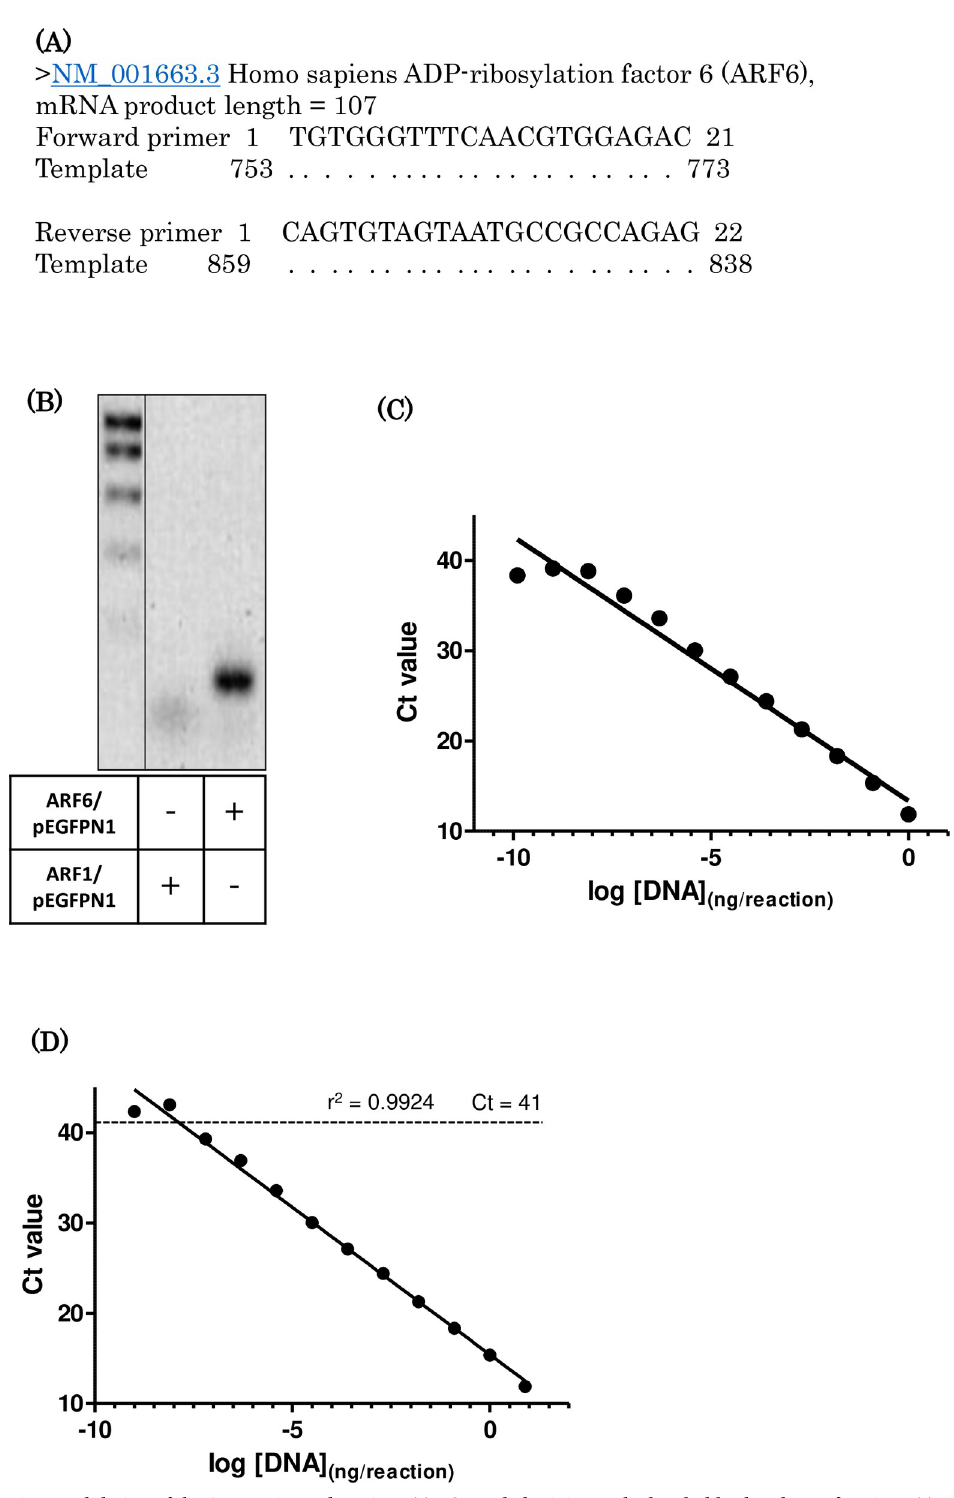
Fig 1. Validation of the ARF6 primers by using RT-PCR and obtaining cycle threshold values by performing RT- qPCR. (A) Alignment of ARF6 primer sequence with ARF6 gene sequence to estimate the ARF6 amplicon size. B) PCR products showing the specificity of ARF6 primers. (B) Agarose gel electrophoresis of PCR products obtained using the ARF6 primers with either ARF6/pEGFP-N1 or Arf1/pEGFP-N1 plasmid as a template (ladder: 1000 bp;